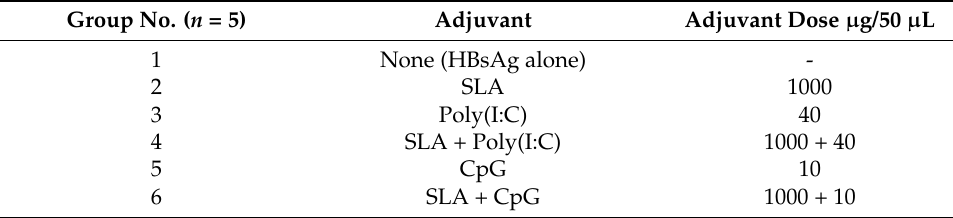
Table 2. Vaccine formulations using Hepatitis B surface antigen (HBsAg) as